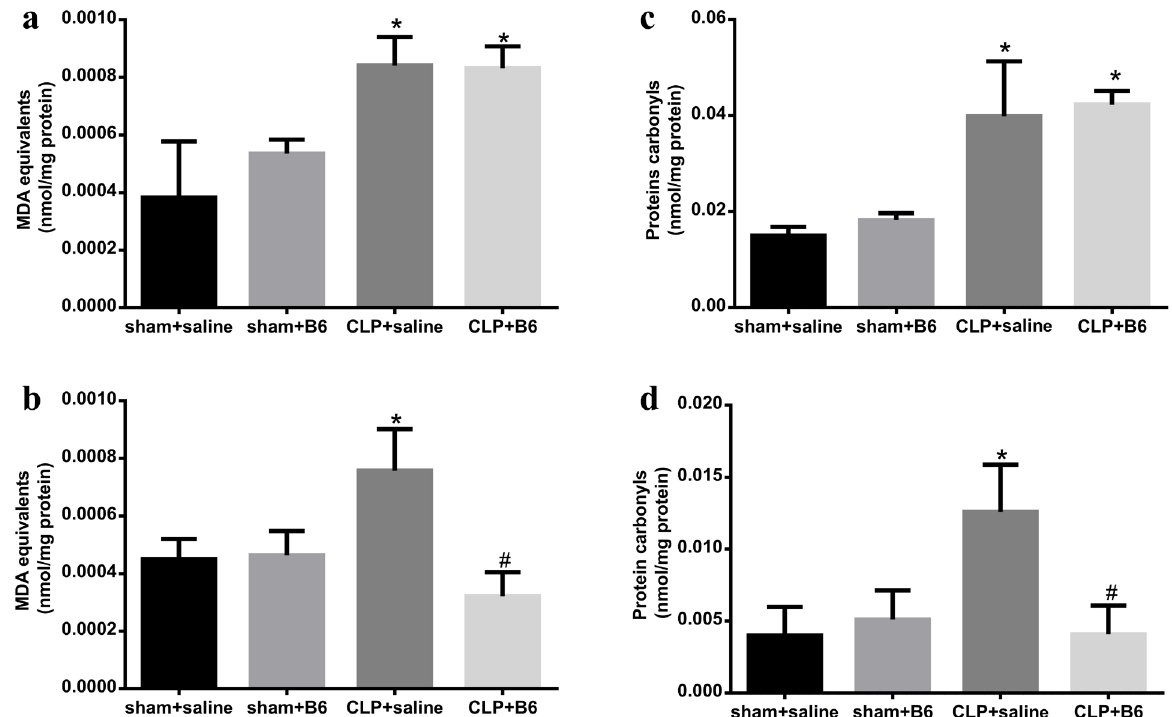
Figure 2 - lipid peroxidation in the lung ( a ) and liver ( b ) and protein carbonylation in the lung ( c ) and liver ( d ) of rats subjected to polymicrobial sepsis and treated with vitamin B6 (600 mg/Kg). Data is expressed as mean ± standard deviation, analyzed by one- way ANOVA with Tukey post-hoc test . *p < 0.05 compared to sham+saline group and # p < 0.05 compared to ClP+saline